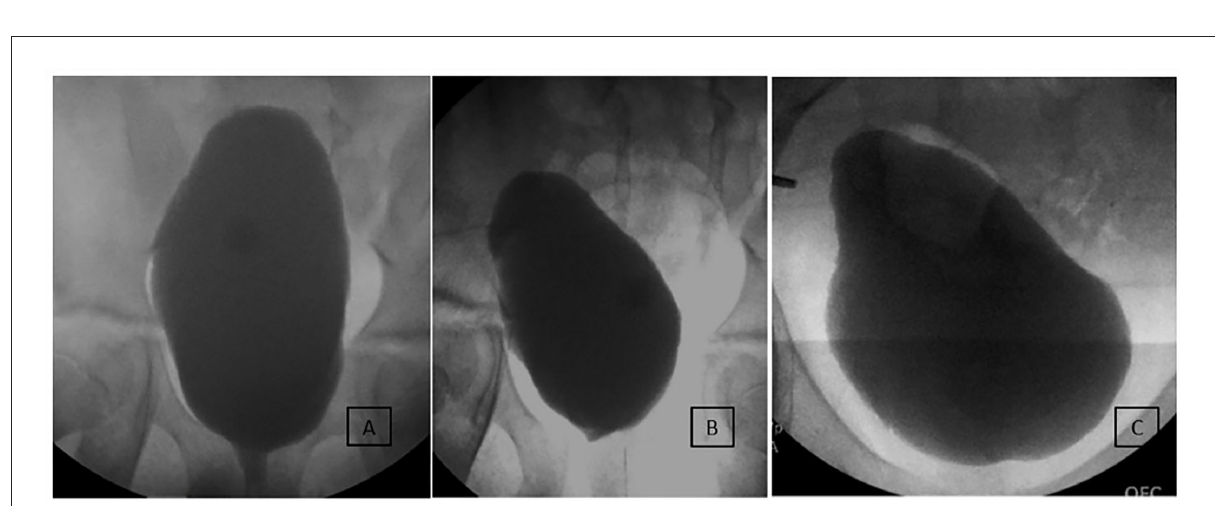
FIGURE3 Long-term imaging of an incontinent 10-year-old male patient undergoing MMBNR with sling only. (A) Preoperative imaging demonstrated increasing bladder neck incompetence with filling but with sphincter effectively occluded by catheter during test. Capacity was 650ml with 180% estimated bladder capacity (EBC), EFP 13cm H 2 O, no NDO or VUR observed. Despite a large capacity and adherence to a CIC regimen, the patient experienced bothersome urinary incontinence and desired further treatment. (B) First postoperative urodynamics show mildly beaked bladder base but no leak or VUR. Capacity 350ml (90% EBC) and EFP 10cm H 2 O on anticholinergics. (C) Nine years after MMBNR with sling, he is continent per urethra without adjunctive procedures and has leakage per continent channel only when noncompliant with CIC and oral